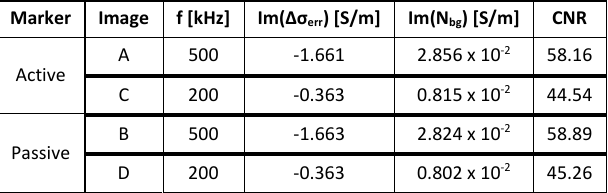
Table 2: Some quantitative data on the erroneous images Im(Δ σ err ) in figure